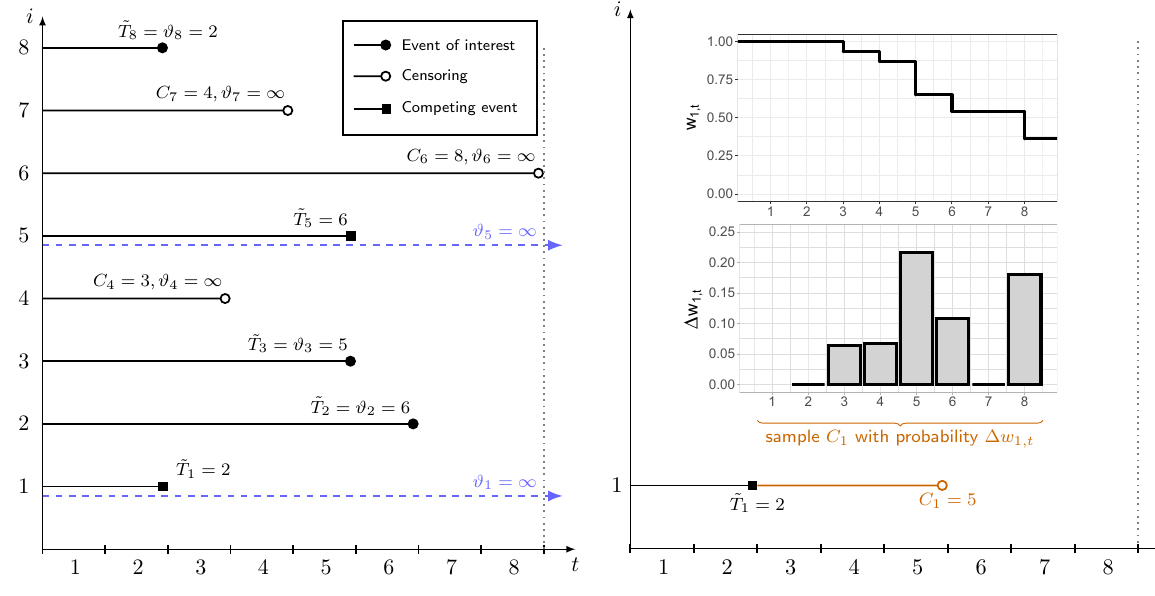
Figure 1. Illustration of the imputation strategy. The left panel presents the subdistribution times of eight randomly sampled individuals. Individuals 1 and 5 experienced the competing event first, implying that their censoring times are unobserved (as illustrated by the time span for i = 1 in the right panel). For these individuals, censoring times are estimated by first calculating estimated subdistribution hazard weights w i , t (see upper right diagram). From that, the weight differences (cid:31) w i , t are calculated and used to sample censoring times C i , which are in turn used to impute the unobserved values of C i = min ( C i , ϑ i ) . Note that the bars in the lower right panel correspond to the heights of the steps in the upper right panel.